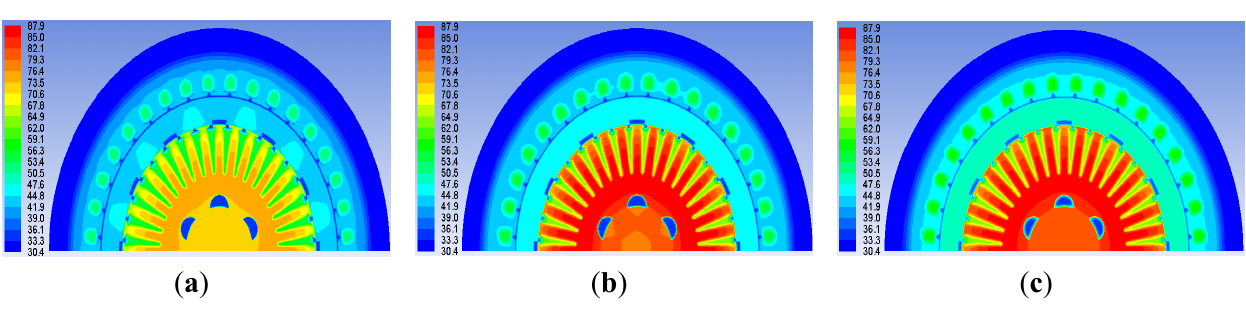
Figure 14. Thermal field distribution of three cross-sections: ( a ) the windward side; ( b ) the middle cross-section; and ( c ) the leeward